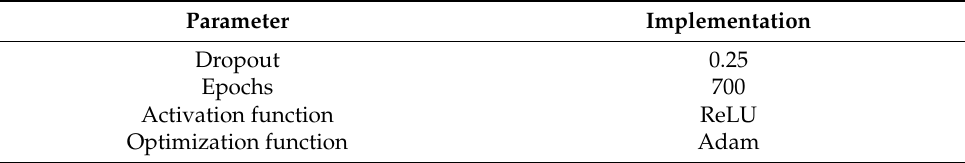
Table 3. Model training